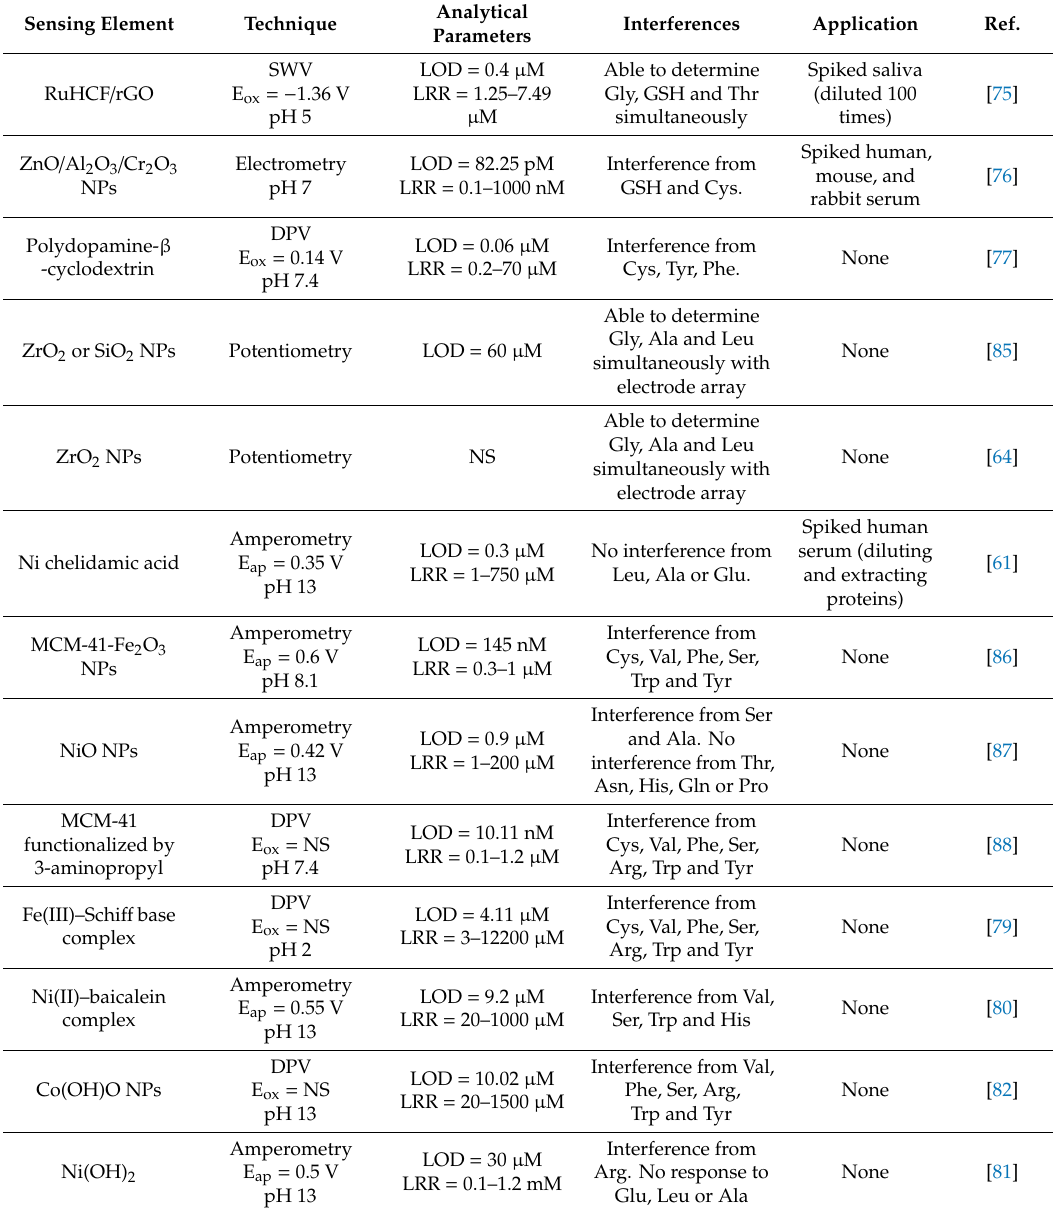
Table 2. Electrochemical sensors reported for the determination of